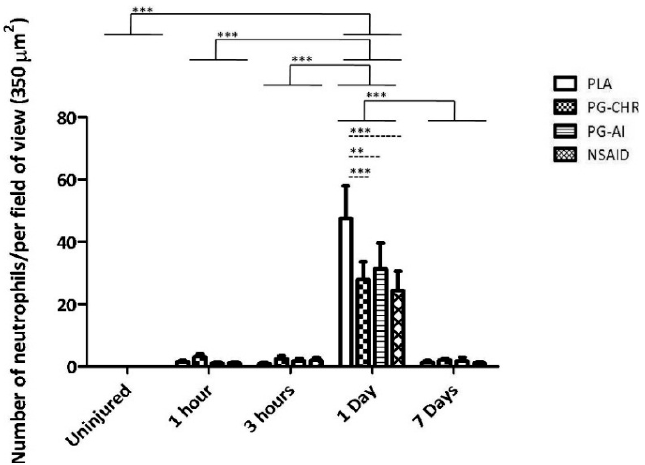
Figure 2 . Neutrophil (His48 stain) infiltration into injured area after contusion injury with/without P. glandulosa treatment. The data are expressed as mean ± SEM. Analysis was done by two-way ANOVA. n = 5 per time-point/per group; Differences over time are indicated by solid lines and broken black lines indicate group differences at specific time points; Significance: All groups: *** p < 0.0001 uninjured vs. 1 day; 1 h vs. 1 day; 3 h vs. 1 day; 1 day vs. 7 days. 1 Day: *** p < 0.0001 PLA vs. PG-CHR; PLA vs. NSAID; ** p < 0.05 PLA vs. PG-AI.